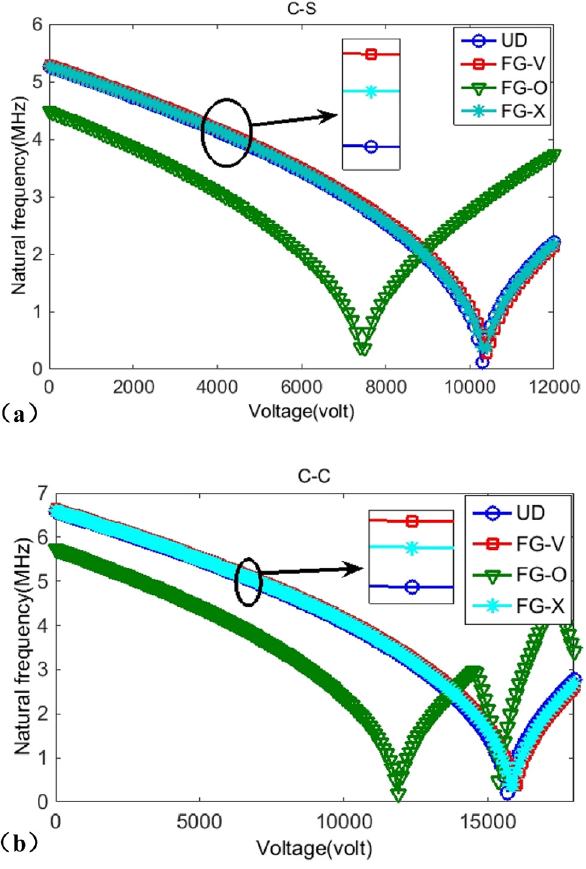
Figure 8: The e ff ect of CNT distribution types on natural frequency in di ff erent boundary where L / R = 0.1, h / R = 0.1, and Ω = 1 MHz [ 139 ] . ( a ) Clamped – simply, ( b ) clamped –